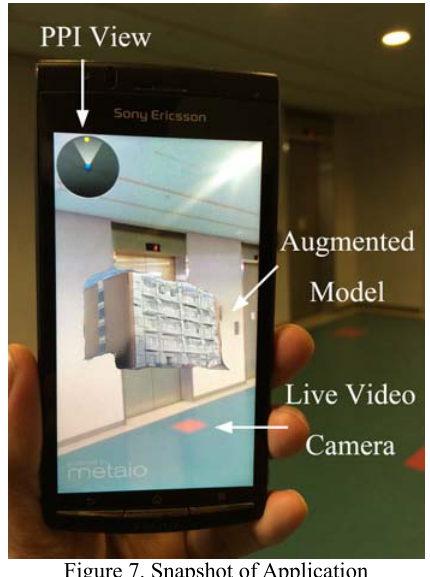
Figure 7. Snapshot of Application